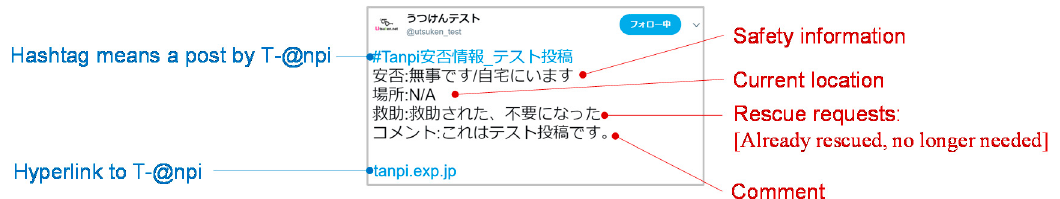
Figure 8. Example of a safety information tweet indicating that the sending user no longer needs a rescue.